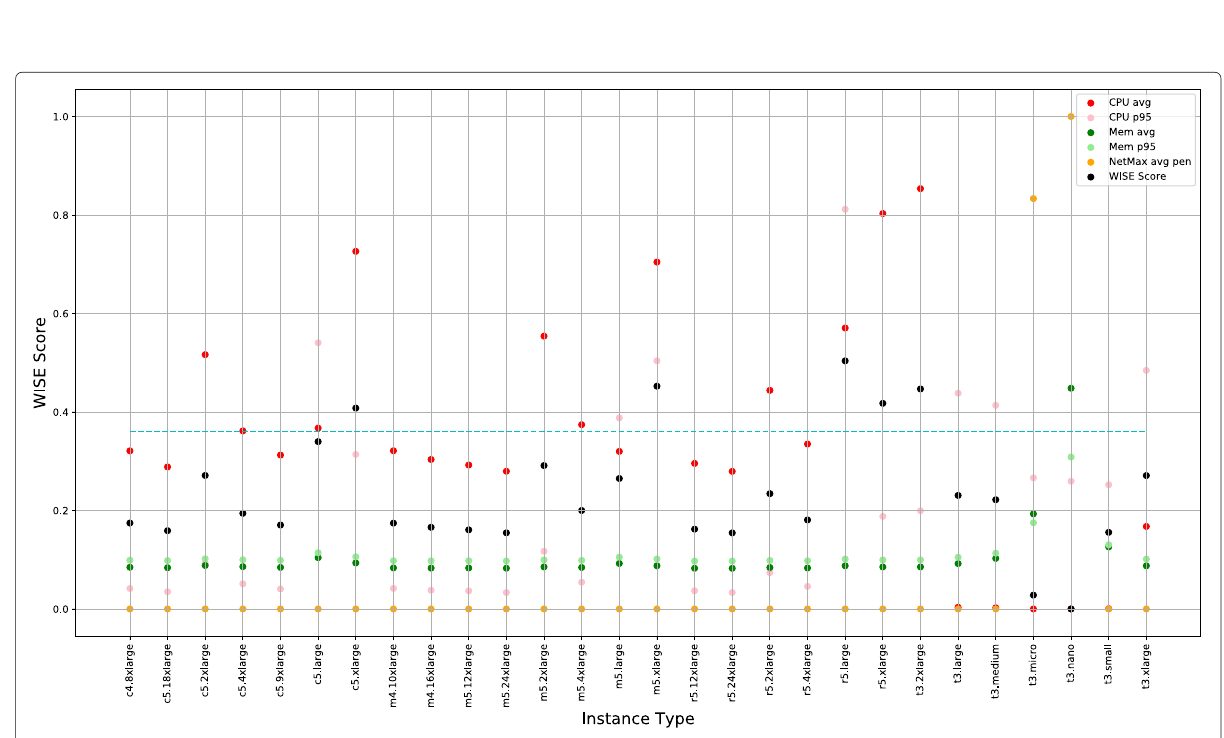
Fig. 7 WISE scores using the exponentially monotone function and (cid:4) 2 -norm for MongoDB